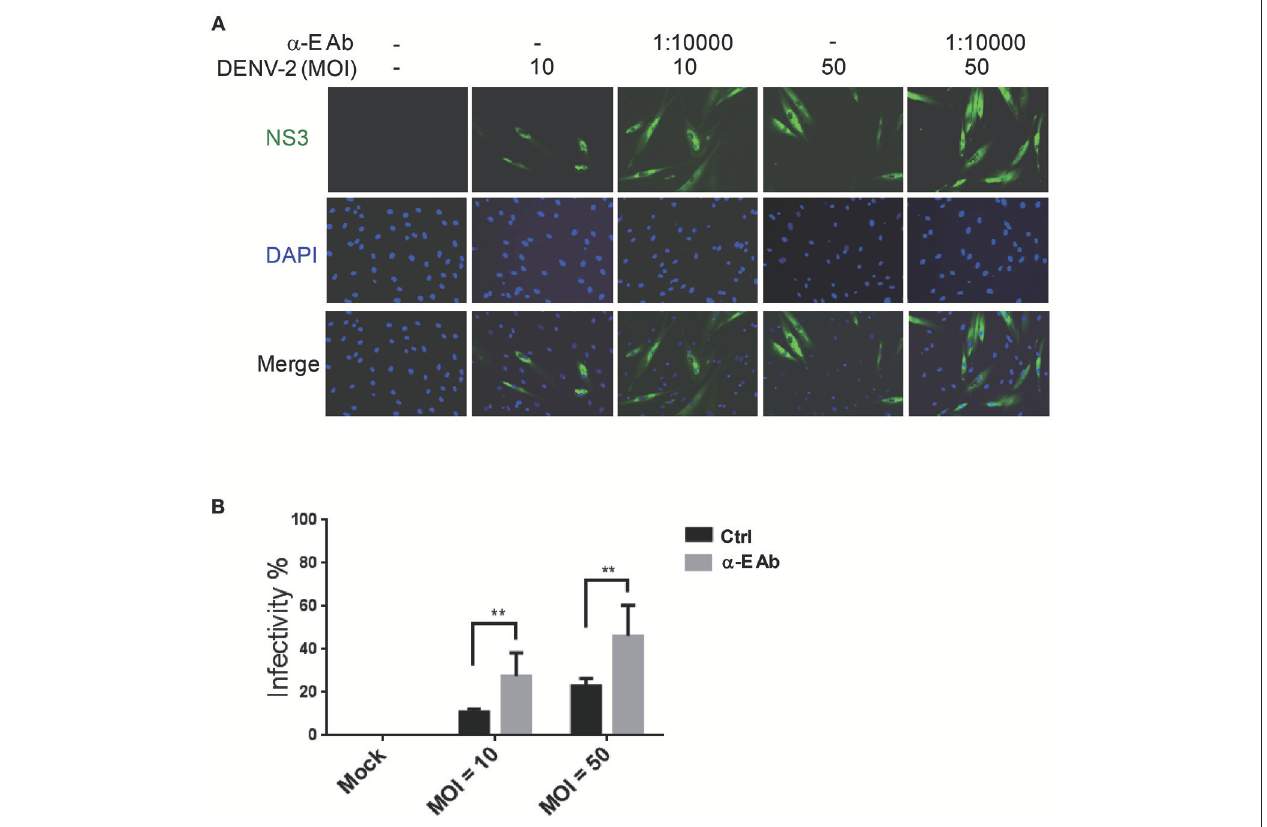
FIGURE 3 | Antibody-dependent enhancement increases DENV-2 infectivity in HFDPCs. (A) HFDPCs (4 × 10 4 cells/well) were infected with DENV-2 (MOI = 10 and 50) with α -E antibody (10,000-fold dilution). After 4 days of infection, HFDPCs were stained with anti-NS3 antibody and DAPI to detect DENV (green color) and cell nuclei (blue color), respectively. (B) The infectivity rate was quantified. Data are mean ± SD of three observation fields. ** P < 0.01 vs. untreated control.